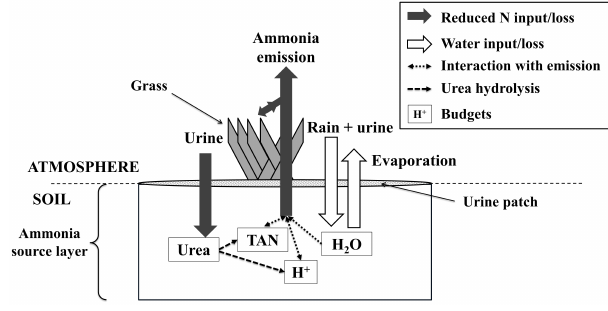
Figure 1. Simplified schematic of the GAG model by Móring et al. (2016), referred to as GAG_patch in this